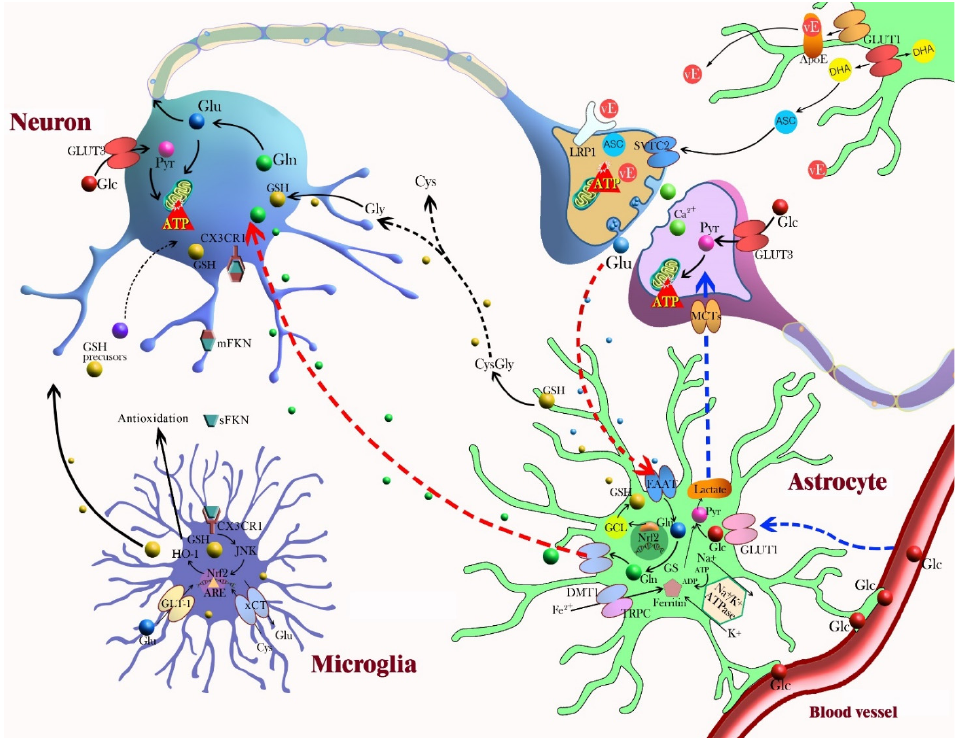
Figure 3. This diagram represents neuron–glia crosstalk involved in neuroprotection and the antioxidant defense mechanism. Astrocyte-neuron: Astrocytes contain a variety of antioxidant molecules, including glutathione (GSH), ascorbate, and vitamin E (vE), and ROS-detoxifying enzymes, such as GSH S-transferase, GSH peroxidase, thioredoxin reductase, and catalase. Astrocytes project the end-feet processes onto brain capillary surface so that astrocytes control the movement of molecules and cells between the vascular compartments and the brain. In the lactate shuttle, astrocytes support neurons by regulating glucose transformation into lactate, which ensures the energetic support of neurons. Neuronal activity triggers glucose metabolism in astrocytes. Glucose is converted to pyruvate by glycolysis and to lactate, which is released from astrocytes and taken up by neurons (blue arrow). Astrocytes can synthesize GSH via activation of Nrf2 and can shuttle GSH precursors to neurons for GSH synthesis. Astrocytes release GSH into the extracellular space and neurons take up the GSH directly or use extracellular neuronal aminopeptidase N to form glycine and cysteine (black arrow). In glutamate uptake and recycling, glutamate from the synaptic space enters astrocytes through EAAT and is converted by glutamine synthetase (GS) to inactive glutamine. After its release and import into neurons, glutamine can be re-converted to glutamate (red arrow). Recycled ascorbate can directly scavenge ROS and act as a cofactor for the recycling of oxidized vE and GSH. Astrocytes take up dehydroascorbic acid (DHA), an oxidation product of ascorbate, from the extracellular space and recycle it back to ascorbic acid. Astrocytes capture and transport excess extracellular K + to the astrocytic syncytium through Na + /K + ATPase. Nrf2 induction of glutamate cysteine ligase (GCL) increases GSH synthesis in astrocytes, and GSH is subsequently exported to the extracellular medium. Astrocytes also participate in metal sequestration in the brain to prevent the generation of free radicals by redox active metals. Microglia-neuron: Microglia contain a high cellular GSH concentration and express and upregulate diverse antioxidant enzymes. The expression of classical antioxidant proteins are controlled by Nrf2 in microglia. Heme oxygenase-1 (HO-1), an antioxidant enzyme upregulated by Nrf2, inhibits NOX2 activation. Fractalkine (FKN) is predominantly expressed on neuronal cells, and microglia and neurons exclusively express the fractalkine receptor (CX3CR1); this is an interesting signaling axis for communication. Abbreviations: ARE, antioxidant response element; ASC, ascorbate; ApoE, apolipoprotein E; xCT, cysteine-glutamate exchanger; Cys, cysteine; DHA, dehydroascorbic acid; DMT1, divalent metal transporter; EAAT, excitatory amino acid transporter; mFKN, membrane-anchored fractalkine; sFKN, soluble fractalkine; CX3CR1, fractalkine receptor; Glc, glucose; GLUT, glucose transporter; Glu, glutamate; Gln, glutamine; GSH, glutathione; GCL, glutamate-cysteine ligase; GS, glutamine synthetase; GLAST, glutamate aspartate transporter; GLT1, glutamate transporter 1; Gly, glycine; HO-1, heme oxygenase-1; JNK, c-Jun amino terminal kinase; LRP, lipoprotein receptor-related protein; MCT, monocarboxylate transporter; Nrf2, nuclear erythroid-related factor 2; Pyr, pyruvate; SVTC-2, sodium-dependent transporter; TRPC, transient receptor potential